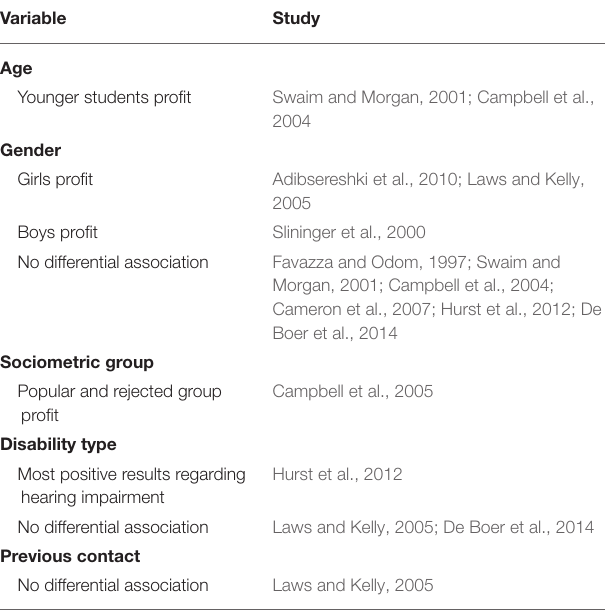
TABLE 6 | Differential associations according to background